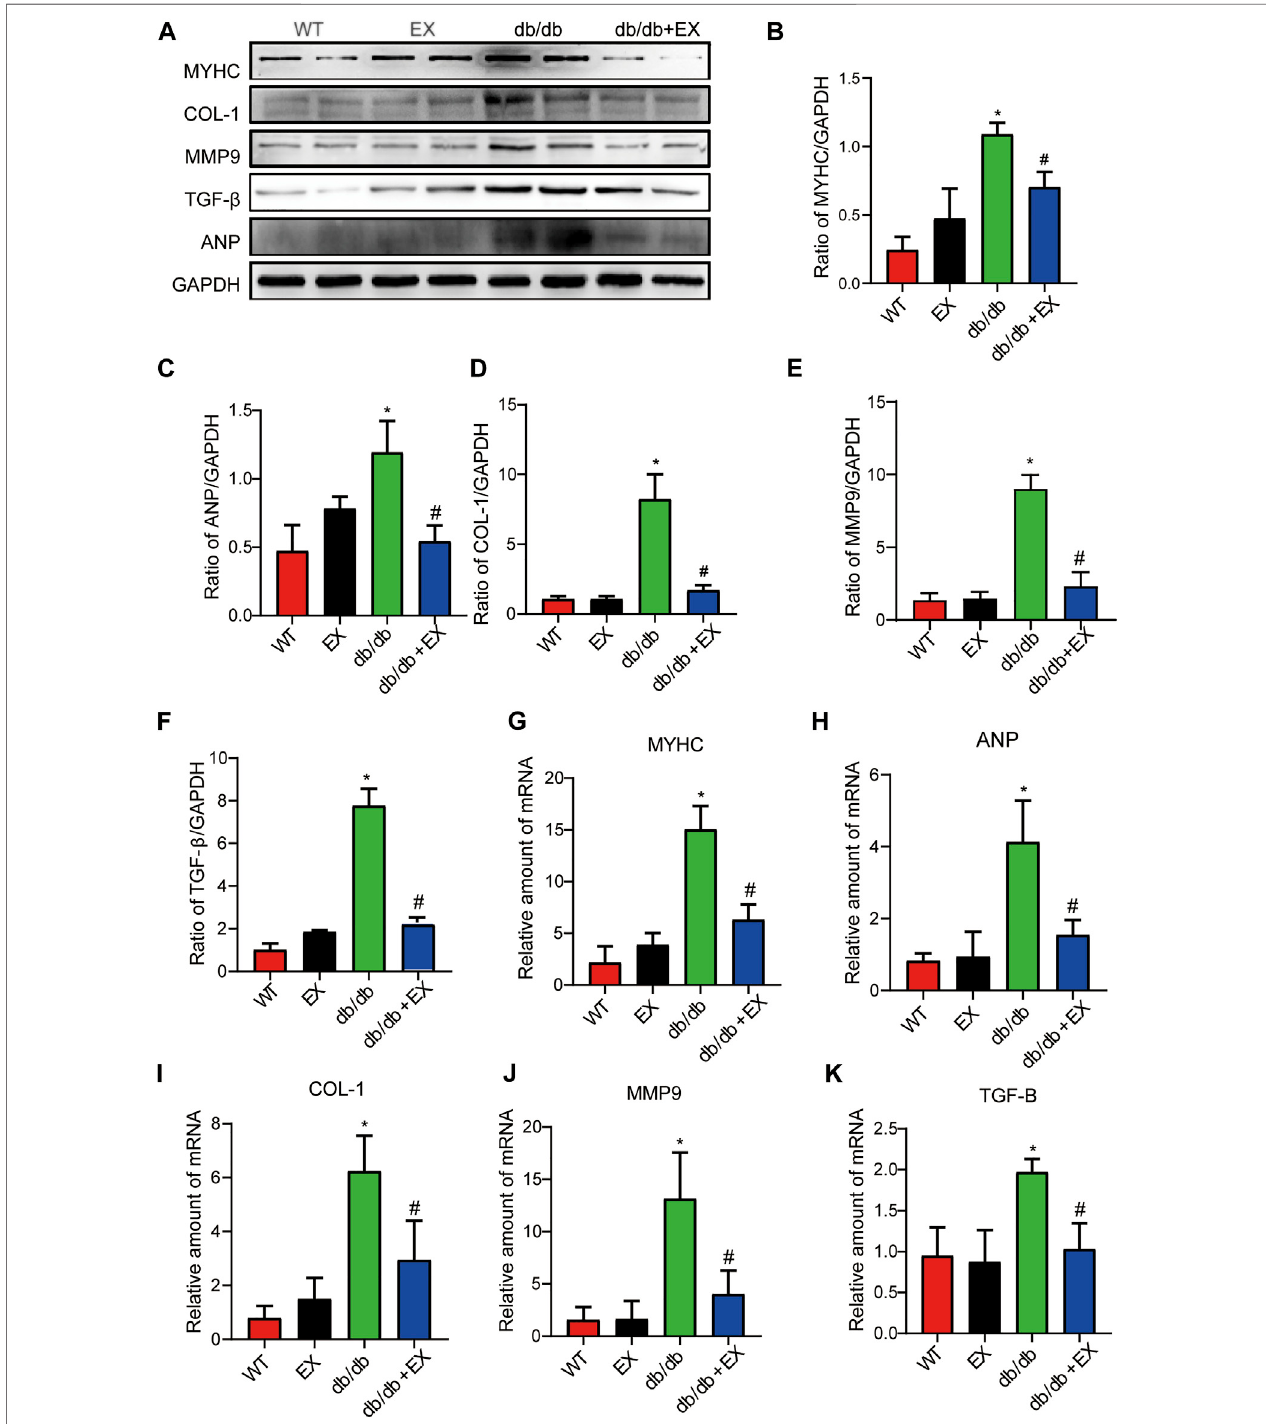
FIGURE 8 | Aerobic exercise ameliorated myocardial remodeling in DM mice. (A – K) Changes in protein and mRNA levels of hypertrophic fi brosis indicators. * p < 0.05 vs. the WT group, # p < 0.05 vs. the DM group.